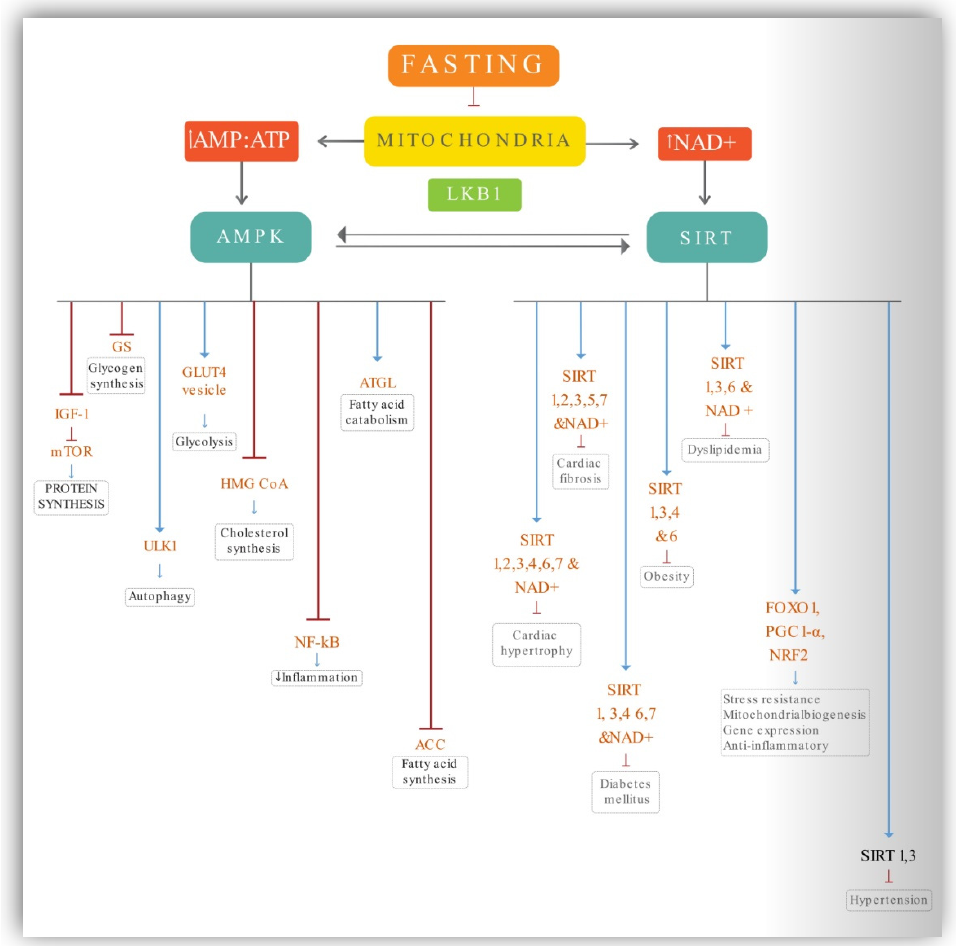
Figure 2. Molecular mechanism of action of fasting. Blue lines—activating action, Red lines—inhibiting action.